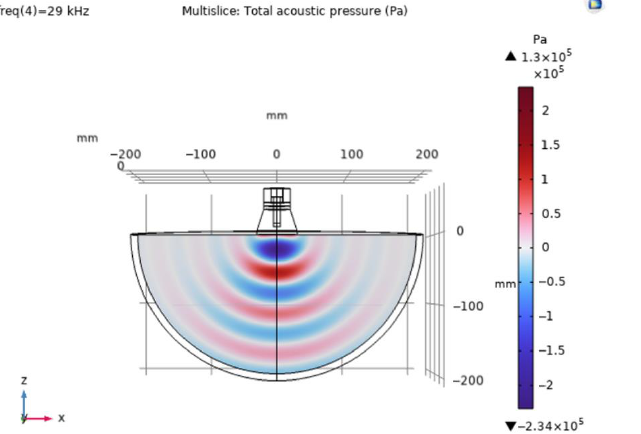
( c ) Figure 7. Propagation of an acoustic field generated by piezoelectric transducer at the first mode in the muscle: ( a ) with flat surface; ( b ) with 58 mm diameter ring-shaped surface; ( c ) with 100 mm diameter ring-shaped surface. The propagation of acoustic waves excited by the flat and ring-shaped surfaces of the piezoelectric transducers in muscle at the second mode are presented in Figure 8. ( a )